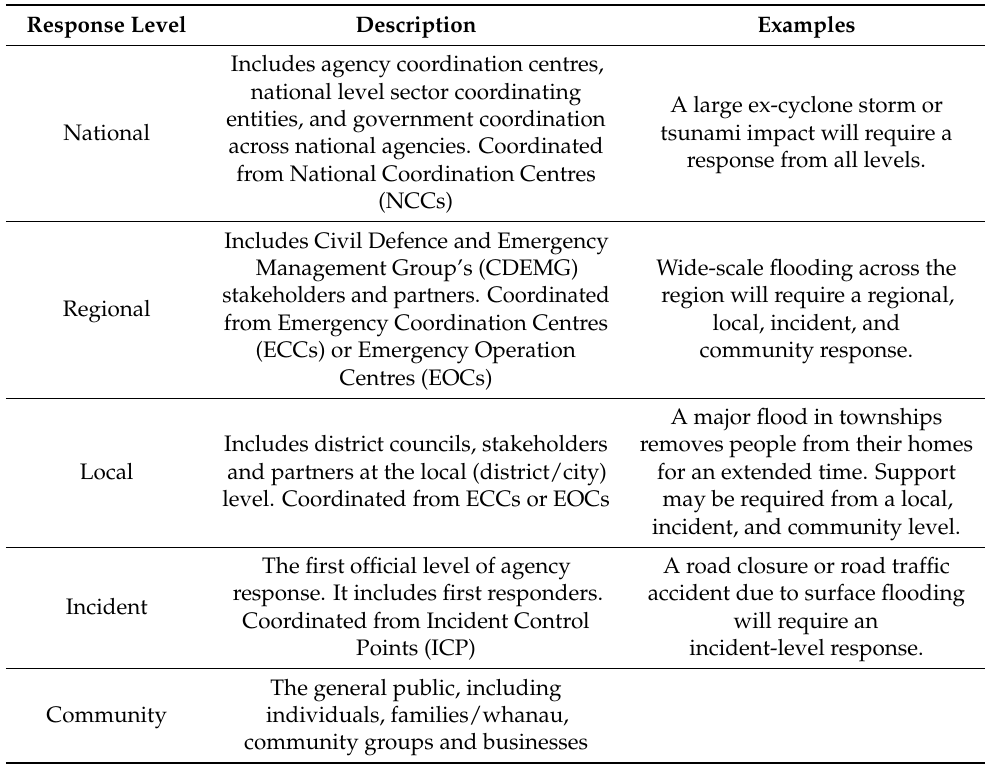
Table 1. Response level of New Zealand, modified from the Northland Emergency Management Group Plan 2021–2026